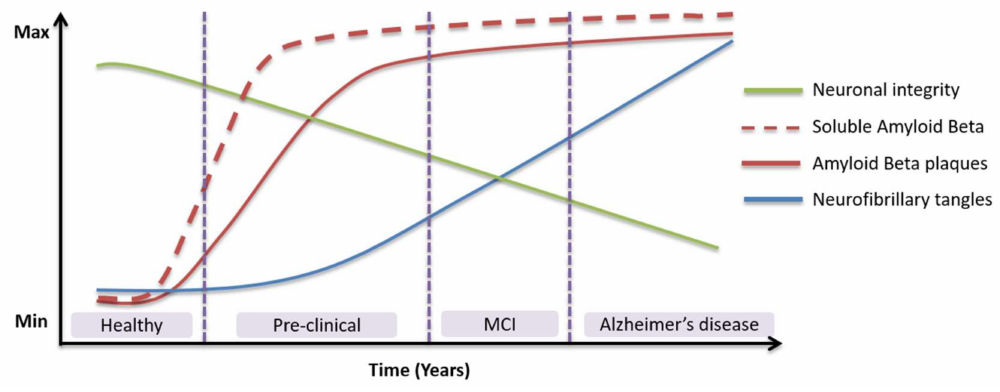
Figure 2. Alterations in levels of established biomarkers in relation to the neuropathology and clinical changes of Alzheimer’s